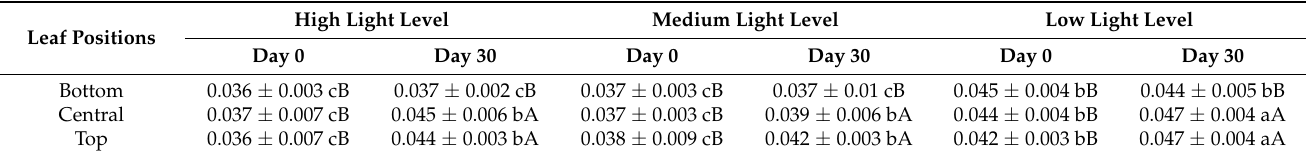
Table 4. Total chlorophyll concentrations (mg · cm − 2 ) of Anthurium × ‘Red’ before and after placement in interior rooms. Leaf Positions Bottom